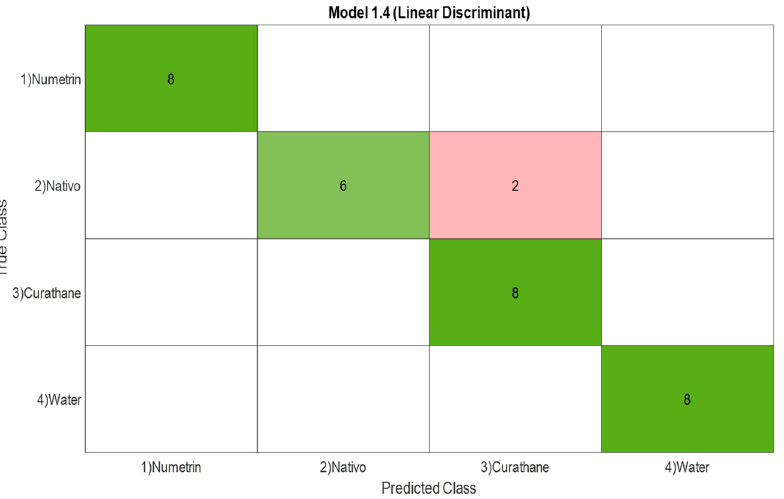
Figure 5. Confusion matrix obtained by applying the medium Gaussian–SVM model for classifying pesticides against distilled water samples.